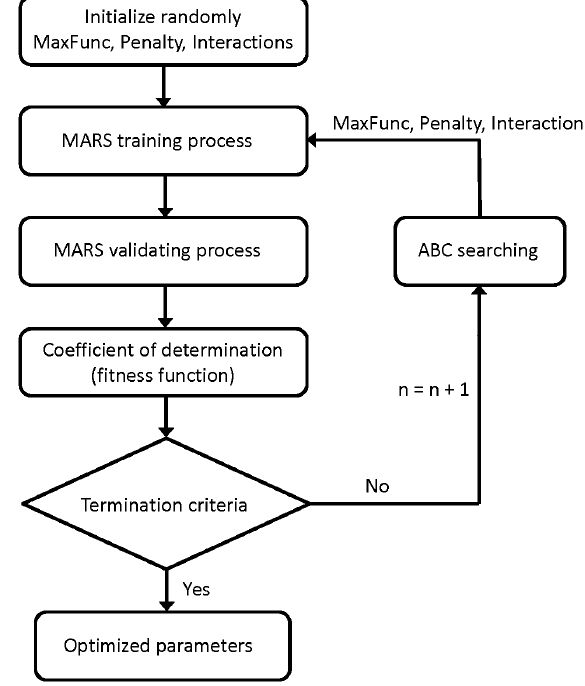
Figure 7. Flowchart of the hybrid ABC–MARS ‐ based model.